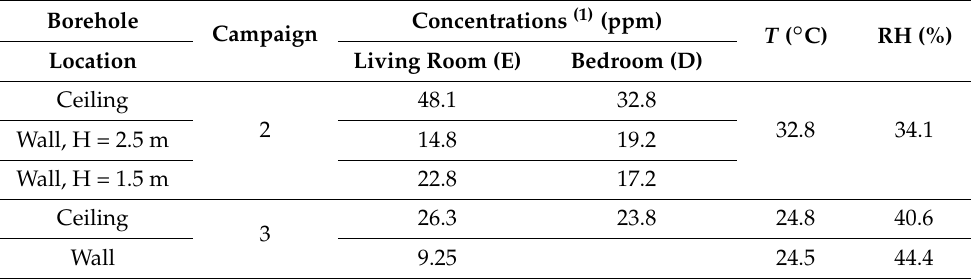
Table 2. The total concentration of contaminants in the air coming out from the boreholes measured using photoionization